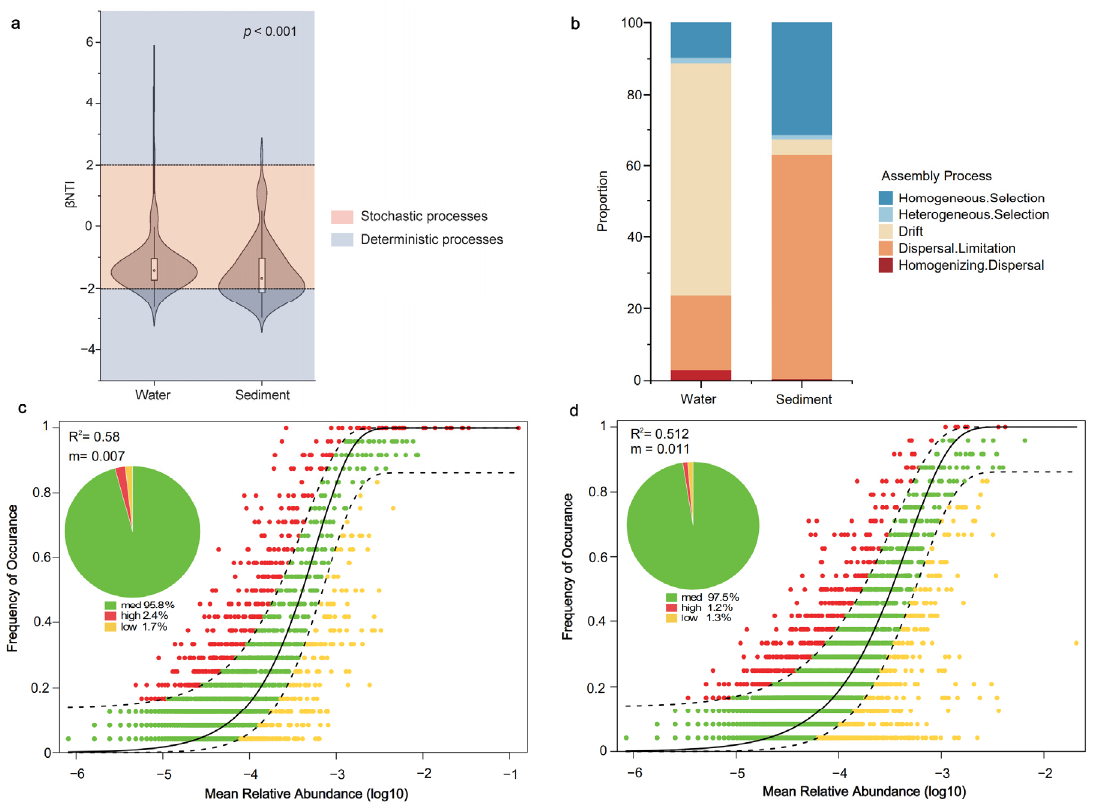
Figure 7. The neutral community model (NCM) and the phylogenetic null model for bacterial communities in the Ningxia section of the Yellow River. ( a ) Distribution of beta nearest taxon index ( β NTI), | β NTI|< 2 indicated a stochastic process, | β NTI|> 2 indicated a deterministic process; ( b ) Relative contributions of deterministic and stochastic processes evaluated by null model framework; ( c ) Fit of the neutral community model (NCM) based on bacterioplankton community; ( d ) Fit of the neutral community model (NCM) based on sedimentary bacteria community. The ASVs represented by red dots showed a higher frequency of occurrence than the model predicts, while those represented by yellow dots were the opposite. The ASVs predicted by the 95% confidence interval of the model are shown as green dots.